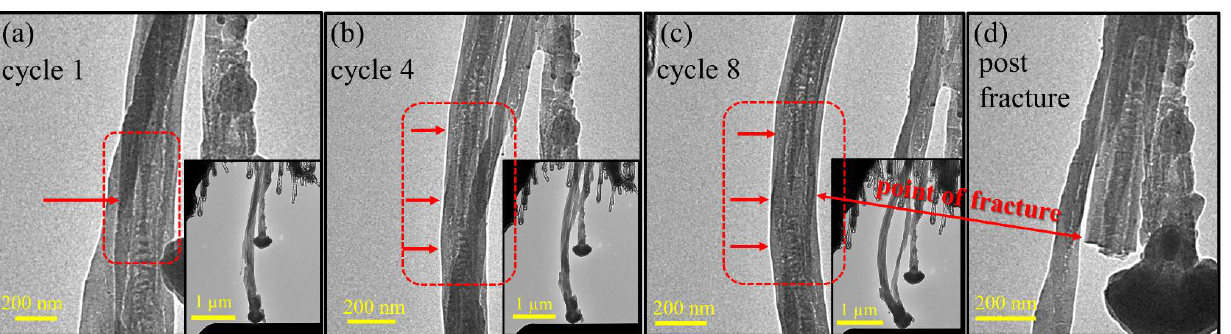
Figure 6. Fracture evolution through cyclic loading. Four TEM snapshots of the bent tube in cycles 1 ( a ), 4 ( b ), 8 ( c ), and post-fracture ( d ). Bright-field mode, 200 kV. ( a ) After cycle 1 a minor defect appeared in the inner void; ( b ) in cycle 4 more defects are observed in the tensile region, marked by the red arrows; ( c ) cycle 8 shows further structural distortion, pointing to ruptures in the tensile region and perhaps a collapse in the inner void. A wave contour is also seen on the compressive side; ( d ) the post-fracture image indicates the location where the fracture evolved, marked by arrows. The near-planar fracture indicates catastrophic brittle behavior.